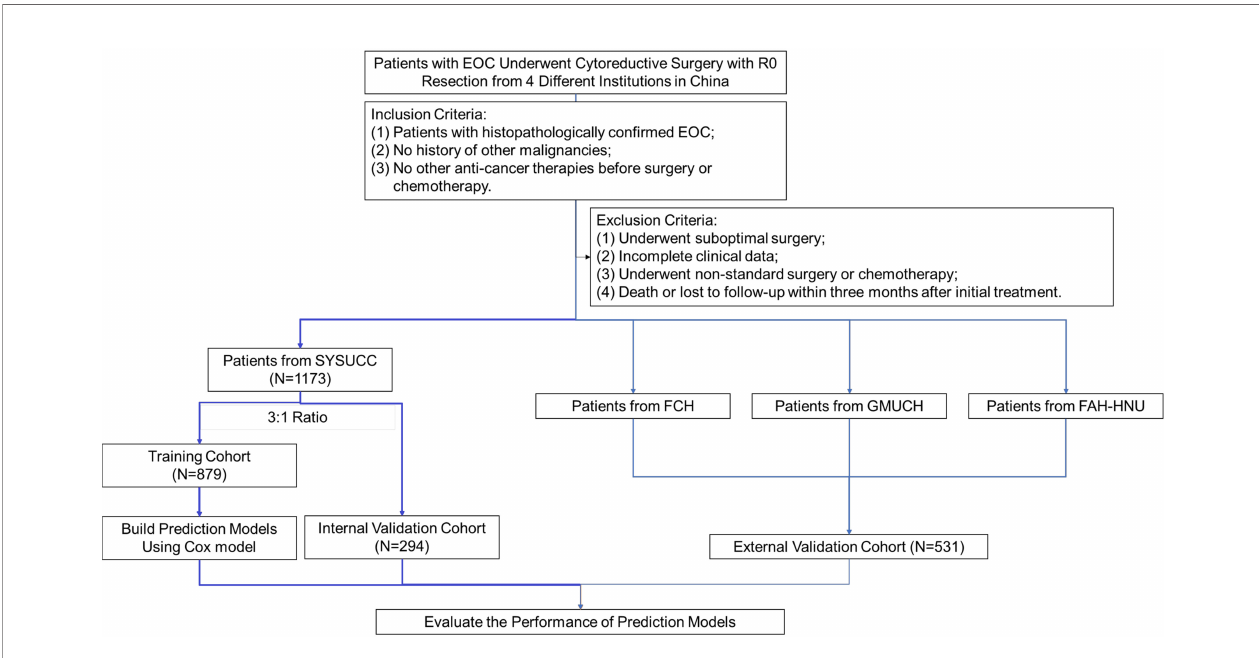
FIGURE 1 | Flowchart of the patient selection